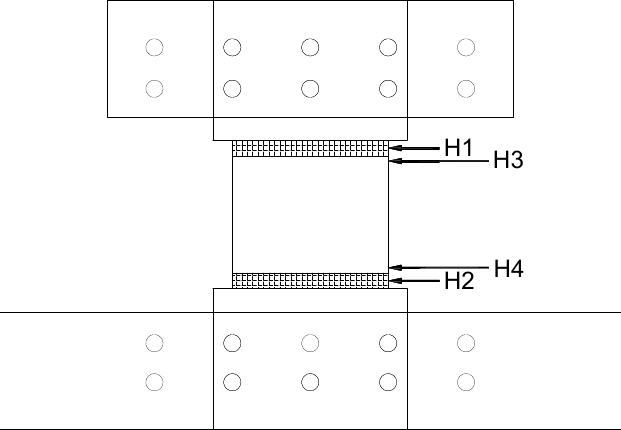
Figure 6. Measurement scheme. 3. Results and Analysis 3.1. Failure Modes The typical failure modes of the welded steel tube dampers are shown in Figure 7, and the typical failure modes of the bolted steel tube dampers are shown in Figure 8.